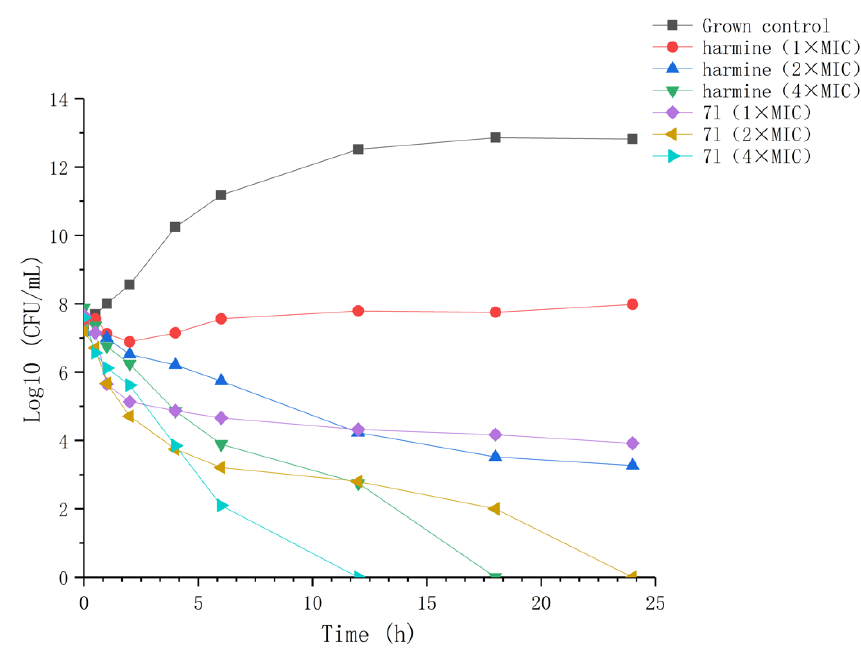
Figure 2. Time-kill kinetics of compound 7l at 1 ×, 2 ×, and 4 × MIC against S. dysgalactiae (ATCC 35666).